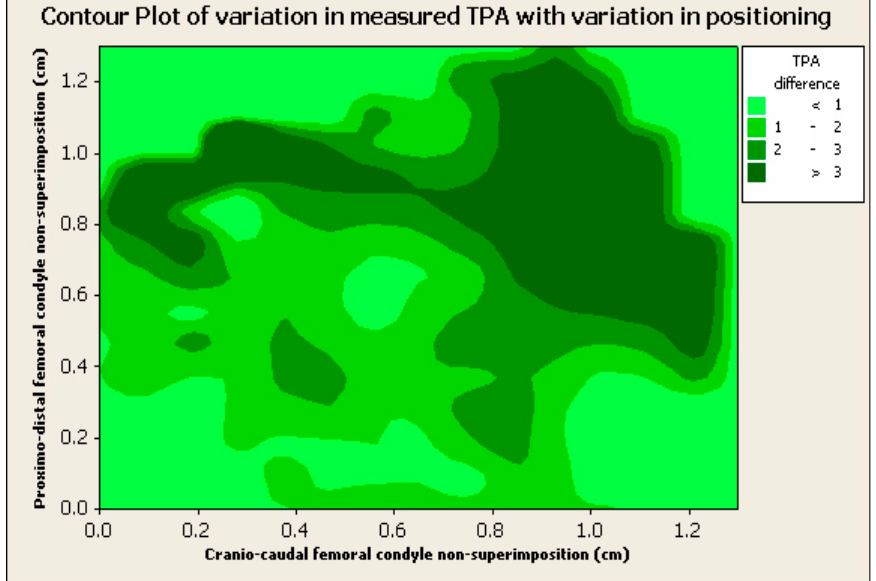
Figure 7. Contour plot of 3 dimensions: TPA angle difference (in degrees) with a gradient of greens, proximo-distal femoral condyle non-superimposition (cm) in the vertical axis and cranio-caudal femoral non-superimposition (cm) in the horizontal axis. Notice the general trend of a higher difference in TPA between “true” and measured TPA with increased non-superimposition in both planes (proximo-distal and cranio-caudal).